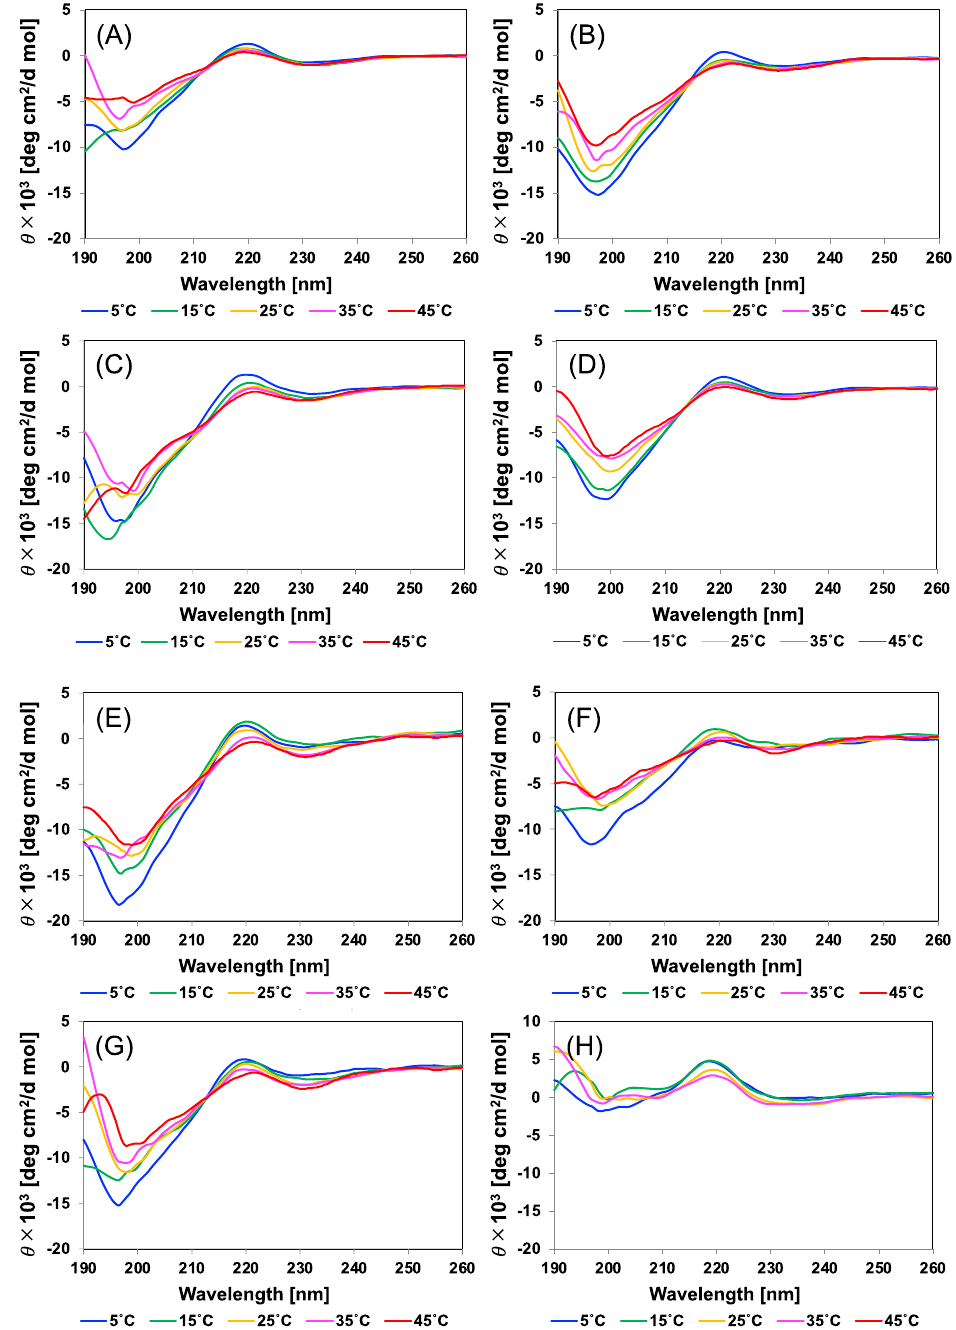
Figure 4. Circular dichroism (CD) spectra of the truncated elastin-like peptide (ELP) analogues. The CD spectra of the truncated ELP analogues are shown. ( A ) (FPGVG) 4 , ( B ) (FPGV) 4 , ( C ) (FPGV) 3 , ( D ) (VFPG) 4 , ( E ) (FPGV)(FPGV)(FPG), ( F ) (FPGV)(FPG)(FPGV), ( G ) (FPG)(FPGV)(FPGV), and ( H ) (FPG) 4